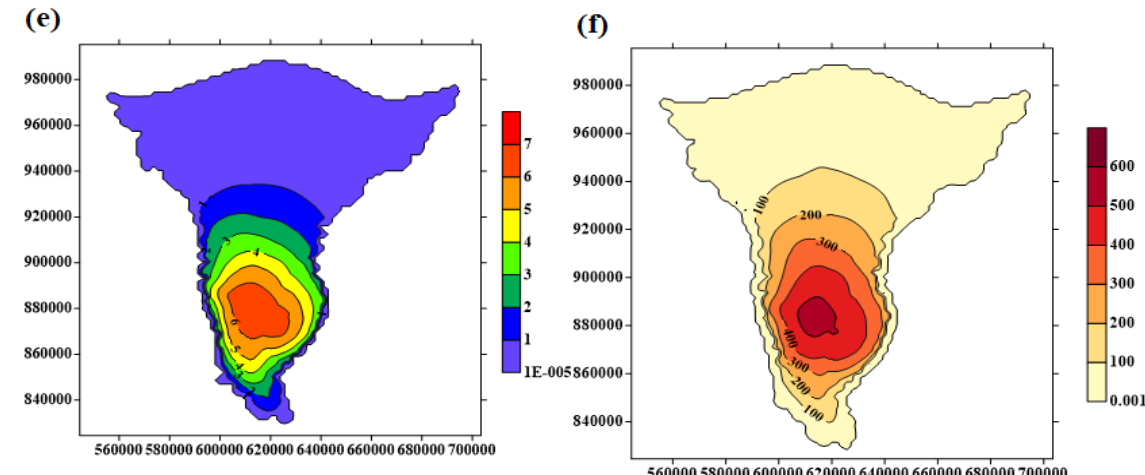
Figure 9. Results of drawdown in (m) and Land subsidence in (mm) in the MND due to increasing abstraction ( a ) GW drawdown during 2010 to 2030, ( b ) LS during 2010 to 2030, ( c ) GW drawdown during 2010 to 2050, ( d ) LS during 2010 to 2050, ( e ) GW drawdown during 2010 to 2070, ( f ) LS during 2010 to 2070. in the MNDA In this stage, the model was used to assess the impact of both increasing the GW abstraction rates to 146%, 193%, and 233% and decreasing recharge rates to 94.4%, 88.8%, and 83.2%, respectively. The results showed that in scenario 8, when the abstraction rate increased by 146% and the recharge rate decreased to 94.4%, the maximum GW draw- down was 2.8 m from the starting level in 2010, and the maximum LS value was 220 mm